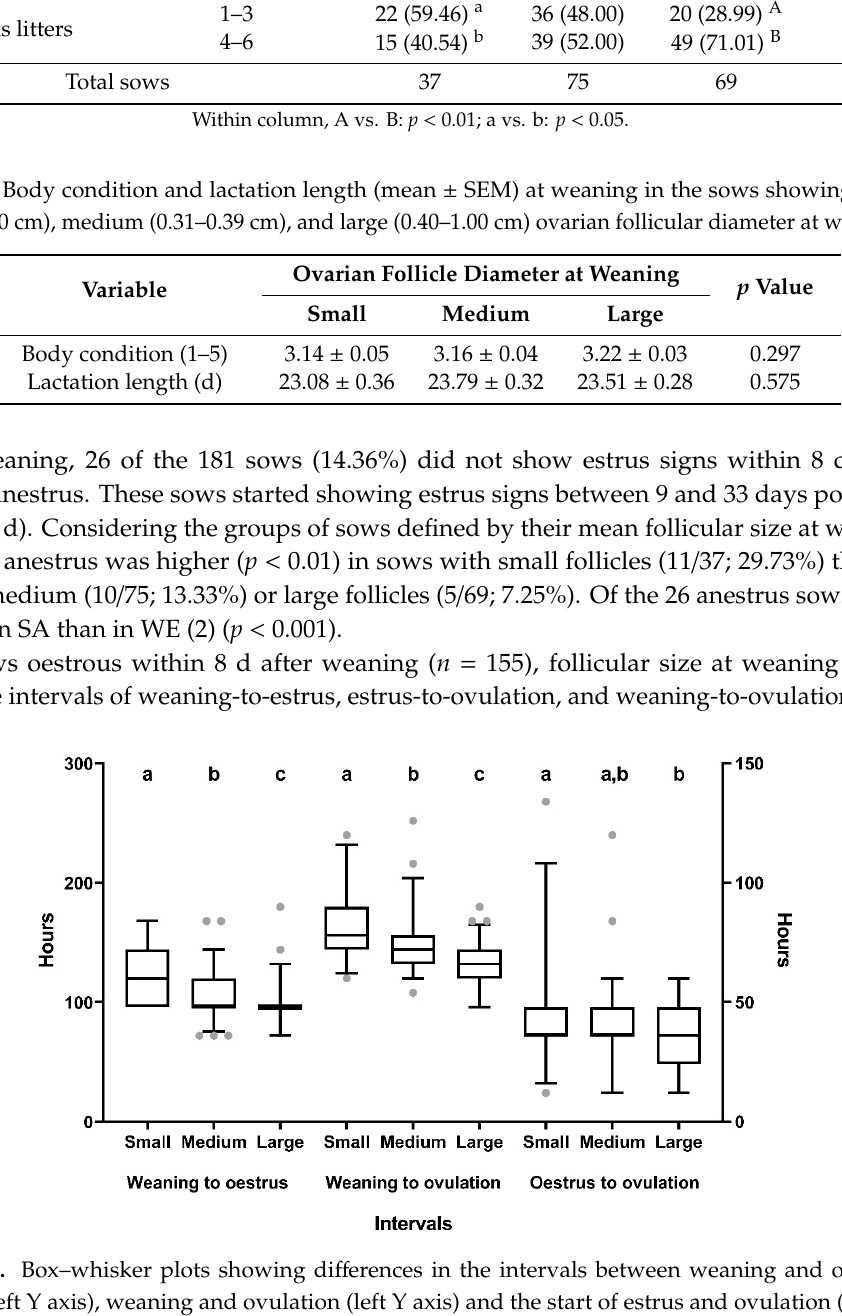
Table 1. Distribution of sows (number and proportion in brackets) showing small (0.20–0.30 cm), medium (0.31–0.39 cm) and large (0.40–1.00 cm) ovarian follicles at weaning between the seasons of the year and the number of previous litters. Data are shown as number and proportion (in brackets).